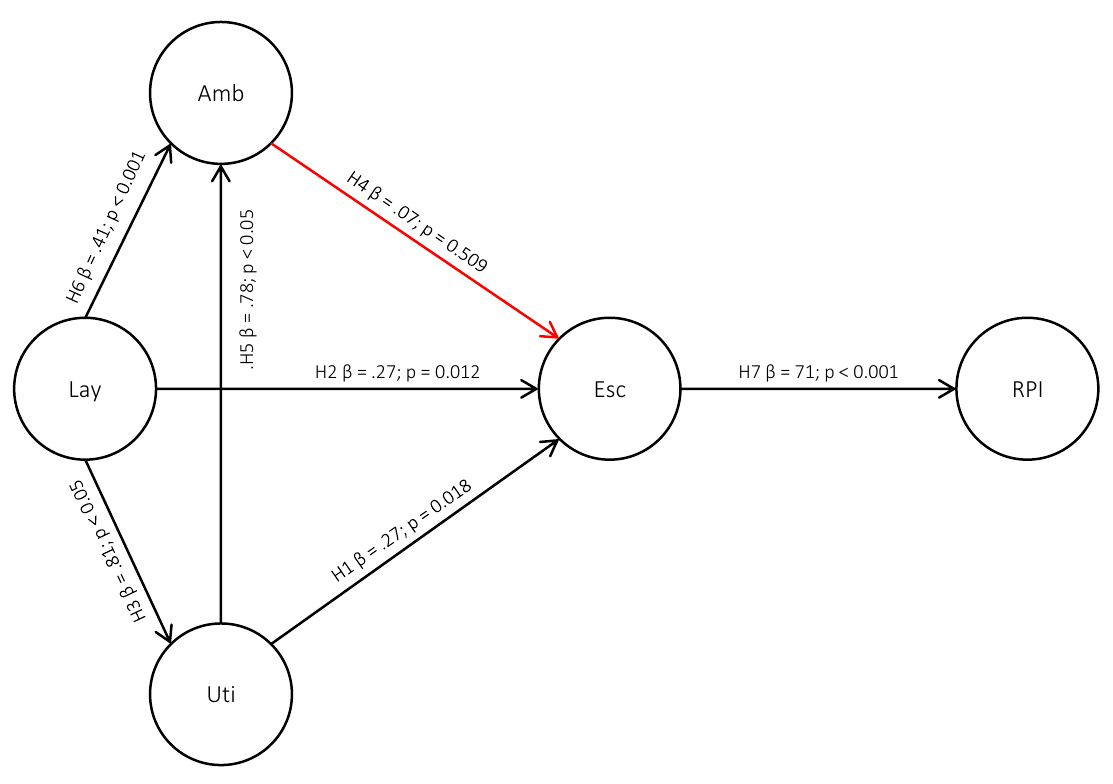
Figure 3. Structural model